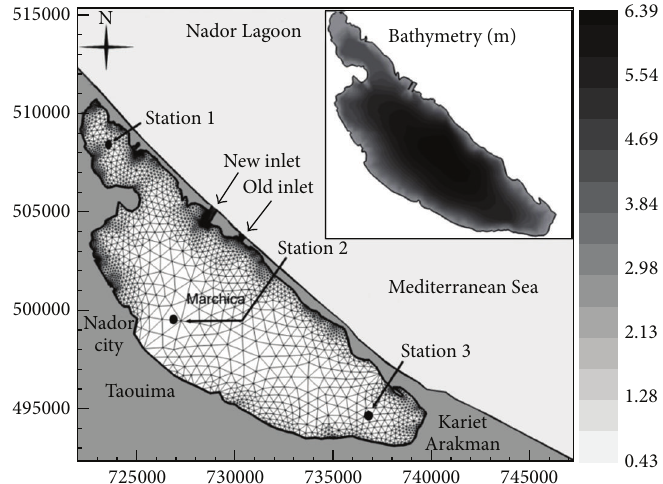
Figure 1: Map of the Nador Lagoon with inset view of the bathymetry contours and showing the triangular mesh used by the numerical